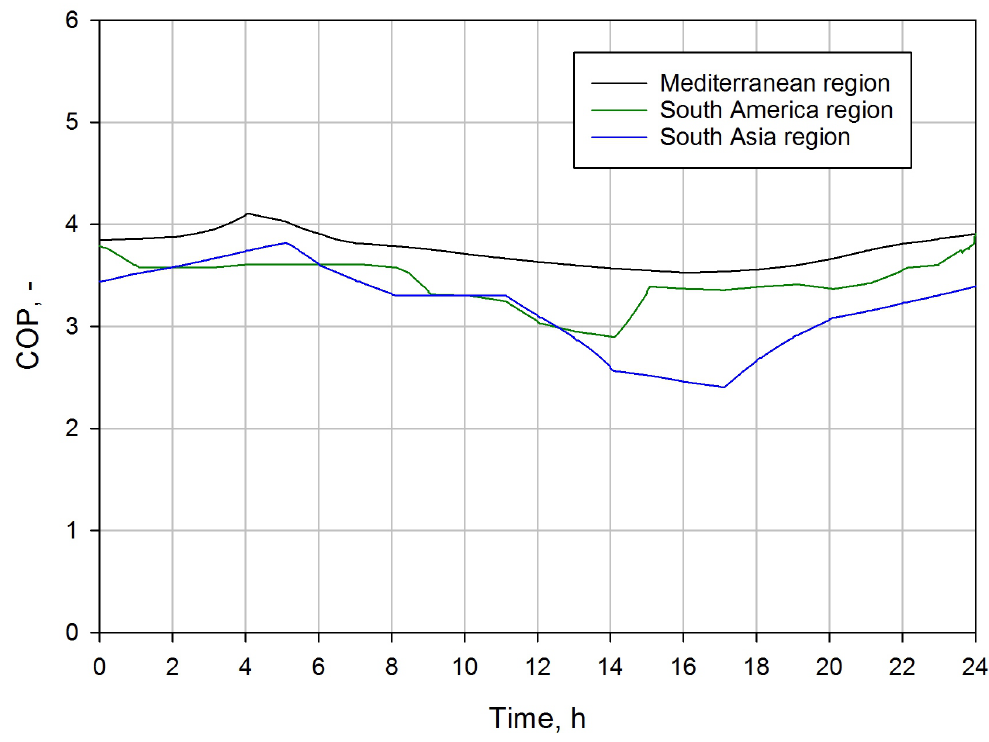
Figure 12. The coefficient of performance for 24 h of the summer campaign in different hot climate